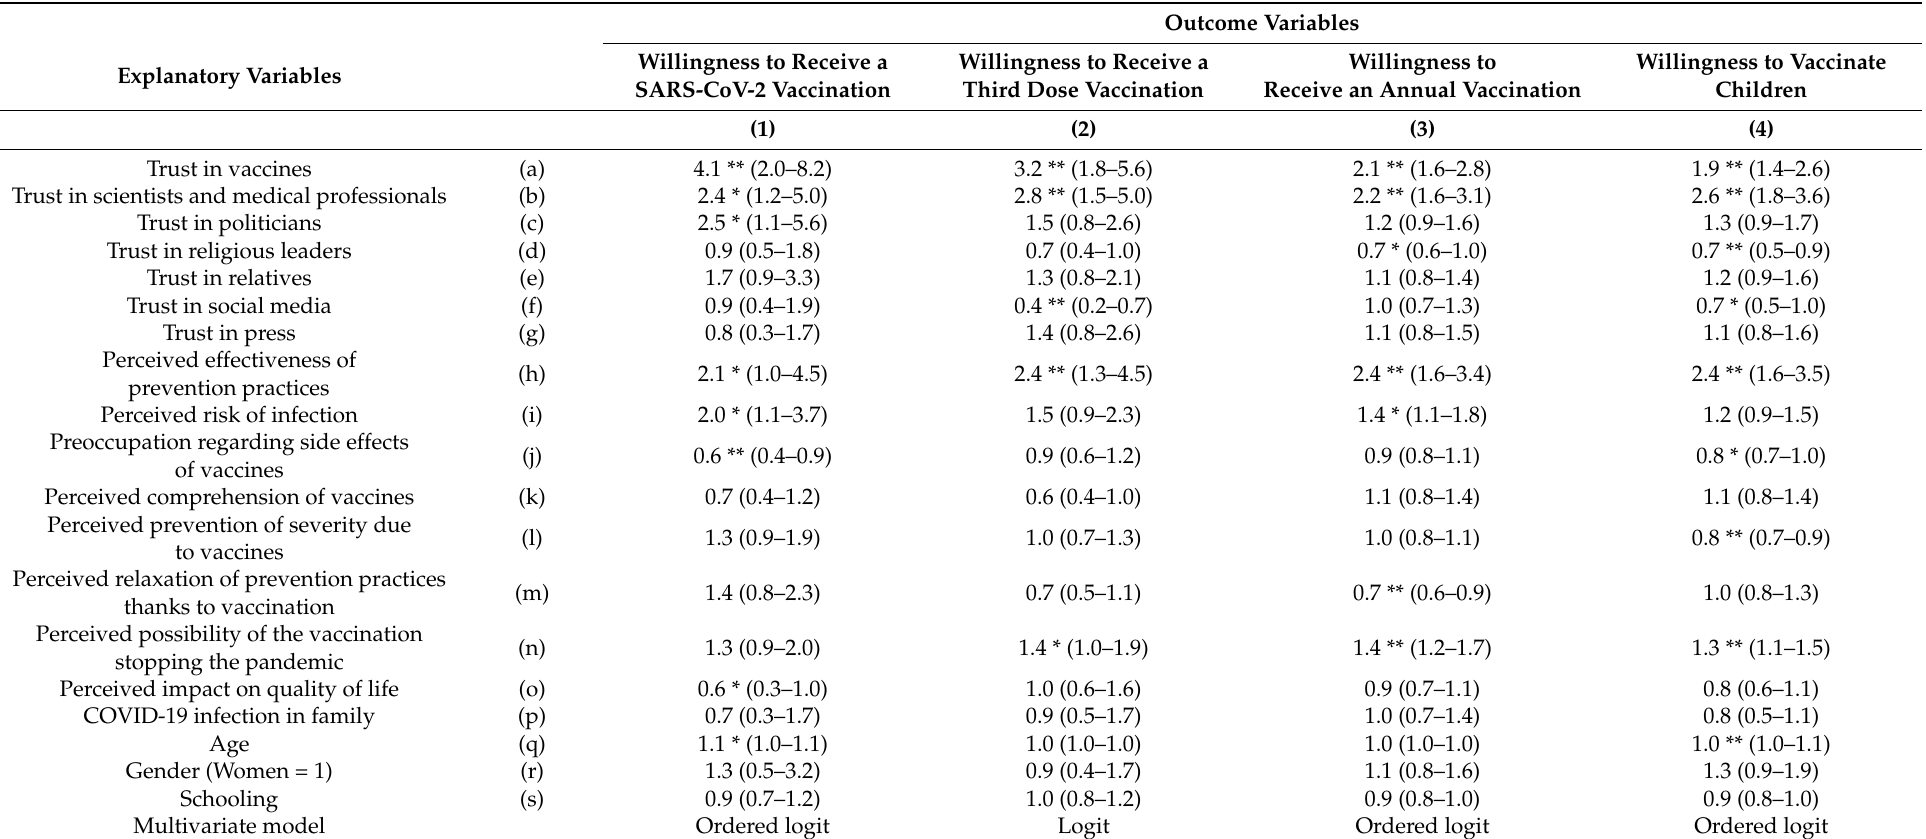
Table 1. Associations regarding the willingness to accept a SARS-CoV-2 vaccination, third dose, annual vaccination, and the vaccination of children, with variables of trust and perception among Chileans ( n =